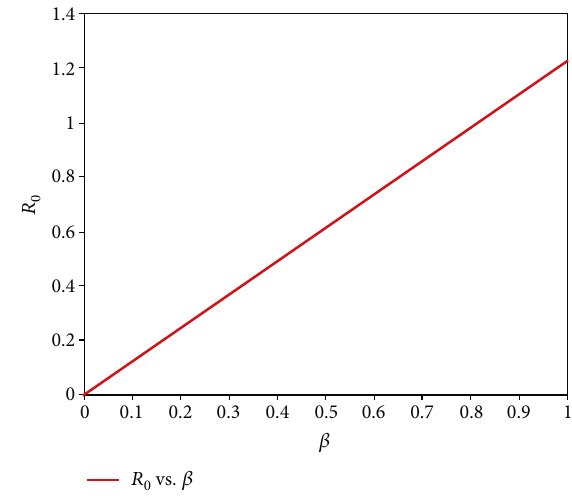
Figure 10: The e ff ect of β on R